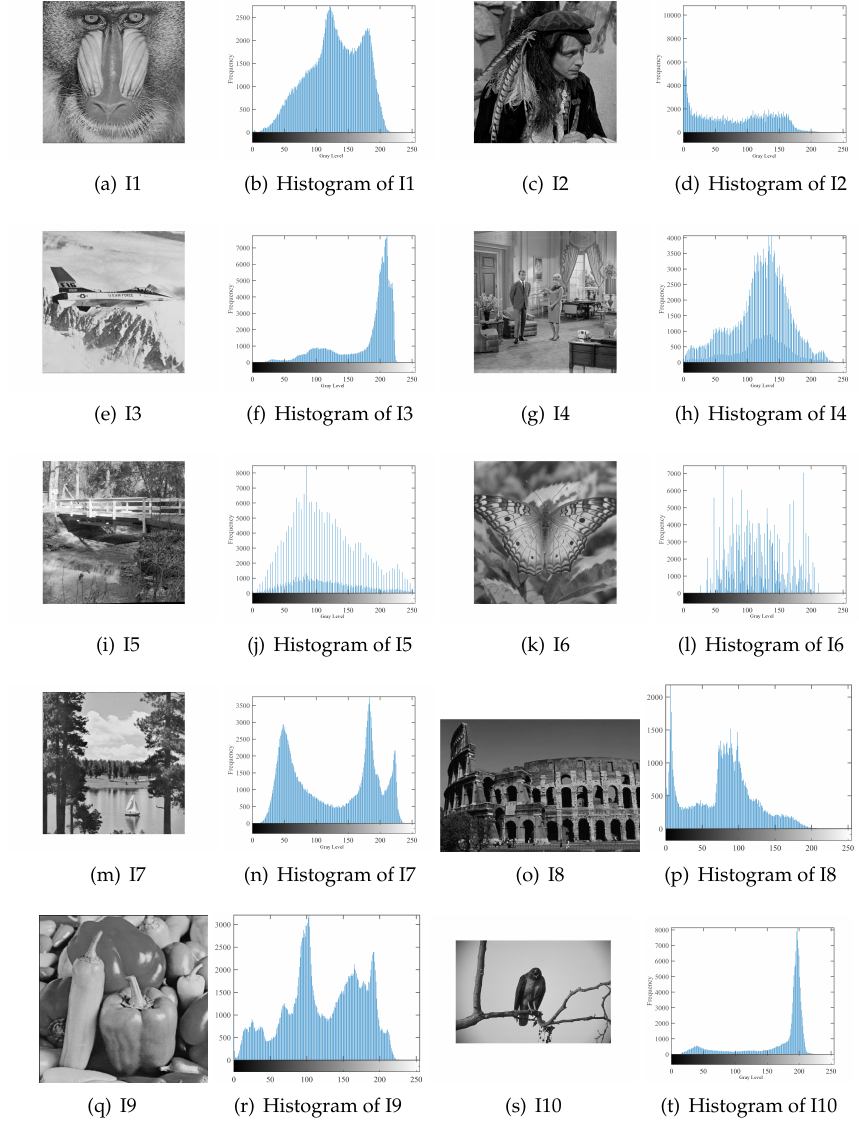
Figure 2. Tested images with their